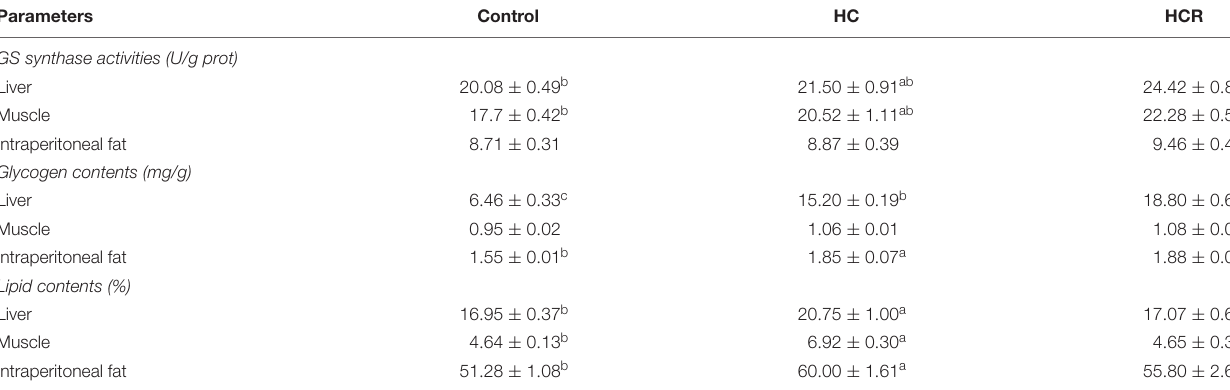
TABLE 4 | Tissue glycogen synthase activities and glycogen and lipid contents of blunt snout bream fed different experimental diets.